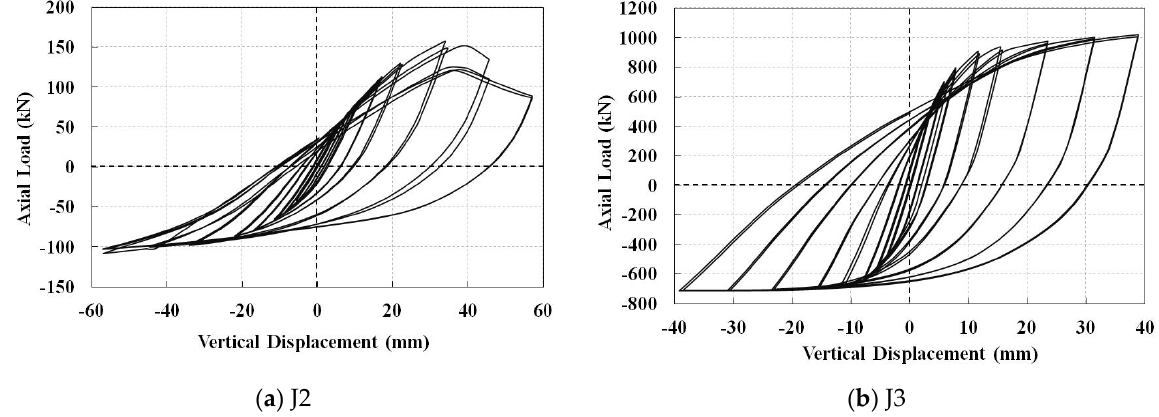
Figure 8. Hysteresis diagrams of the non-retrofitted J2 and J3 models, including the welding process.